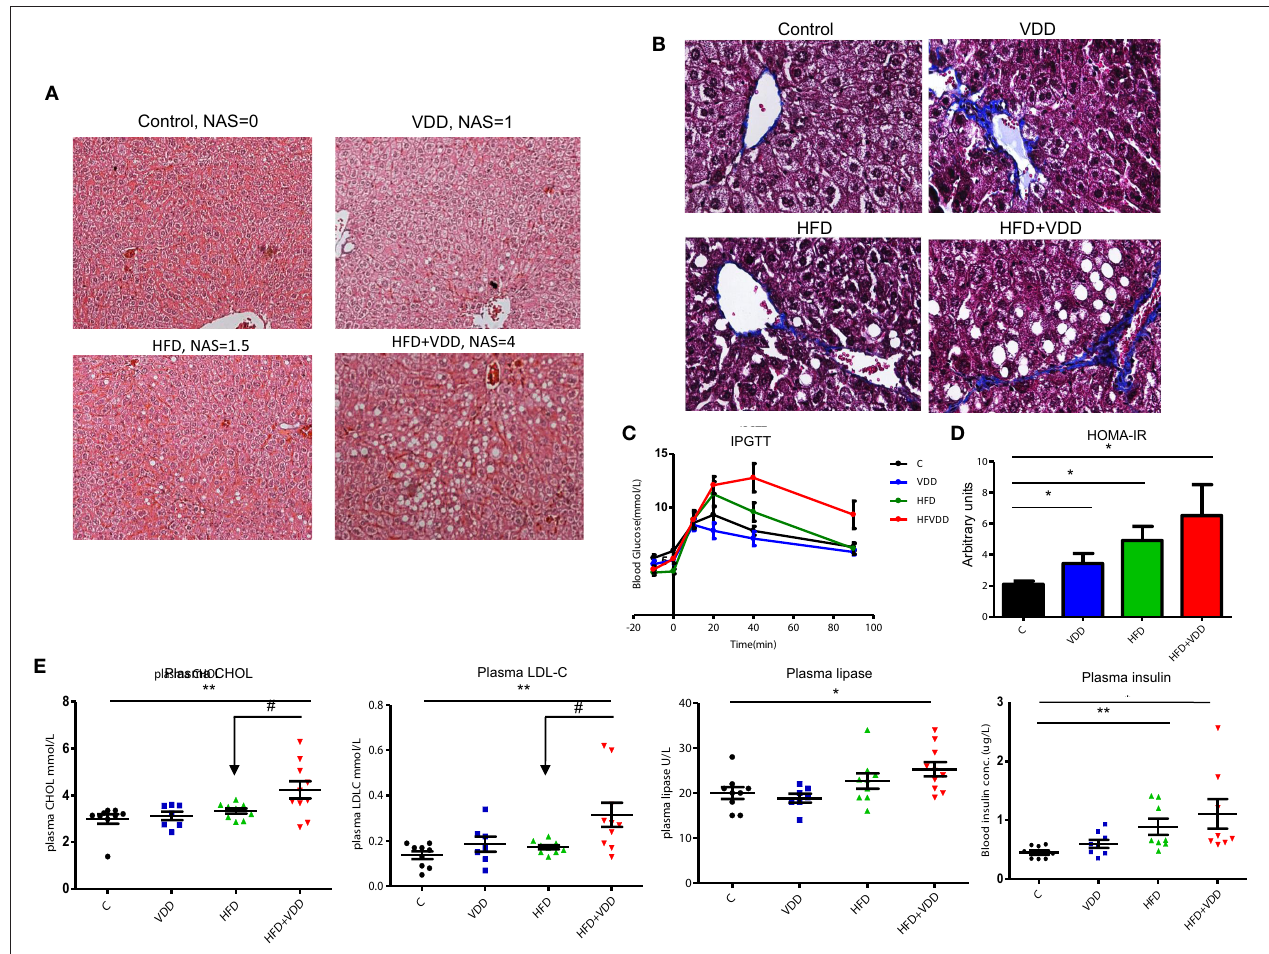
FIGURE 1 | High fat feeding is not sufficient to induce robust hepatic steatosis and metabolic disorders, but additional vitamin D deficiency is needed. Balb/C mice were fed for 18 weeks in the following 4 conditions ( n = 10 per group): (1) control chow, AIN93 with standard VD 3 supplement at 1000 IU/kg, (2) vitamin D deficient AIN93 chow, VDD, (3) high fat diet (60% calorie from fat) with standard VD 3 supplement, HFD, (4) vitamin D deficient high fat diet, HFD + VDD. (A) Representative images of liver tissues, H&E staining. NAS scores are indicated. (B) Representative images of liver tissues, Masson’s Trichrome staining. (C) Intraperitoneal glucose tolerance test (IPGTT). (D) Homeostatic model assessment (HOMA-IR). (E) Plasma total cholesterol, low-density lipoprotein (LDL), plasma lipase, and plasma insulin levels in fast. Data represent two independent experiments ( n = 6–10 mice/group for each measurement). Error bars represent the SEM